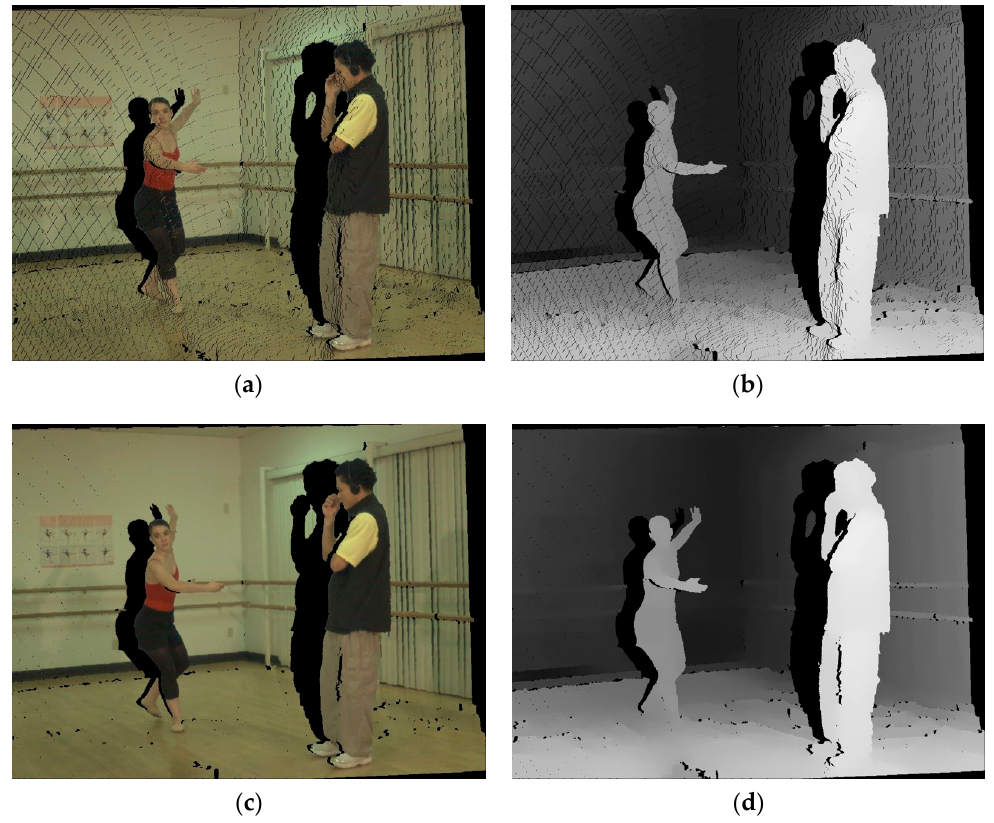
Figure 9. Results of 3D inverse warping rendering (left view). ( a ) and ( b ) the virtual view and the corresponding depth map. ( c ) and ( d ) Results of 3D inverse warping rendering corresponding to ( a ) and ( b ), respectively.